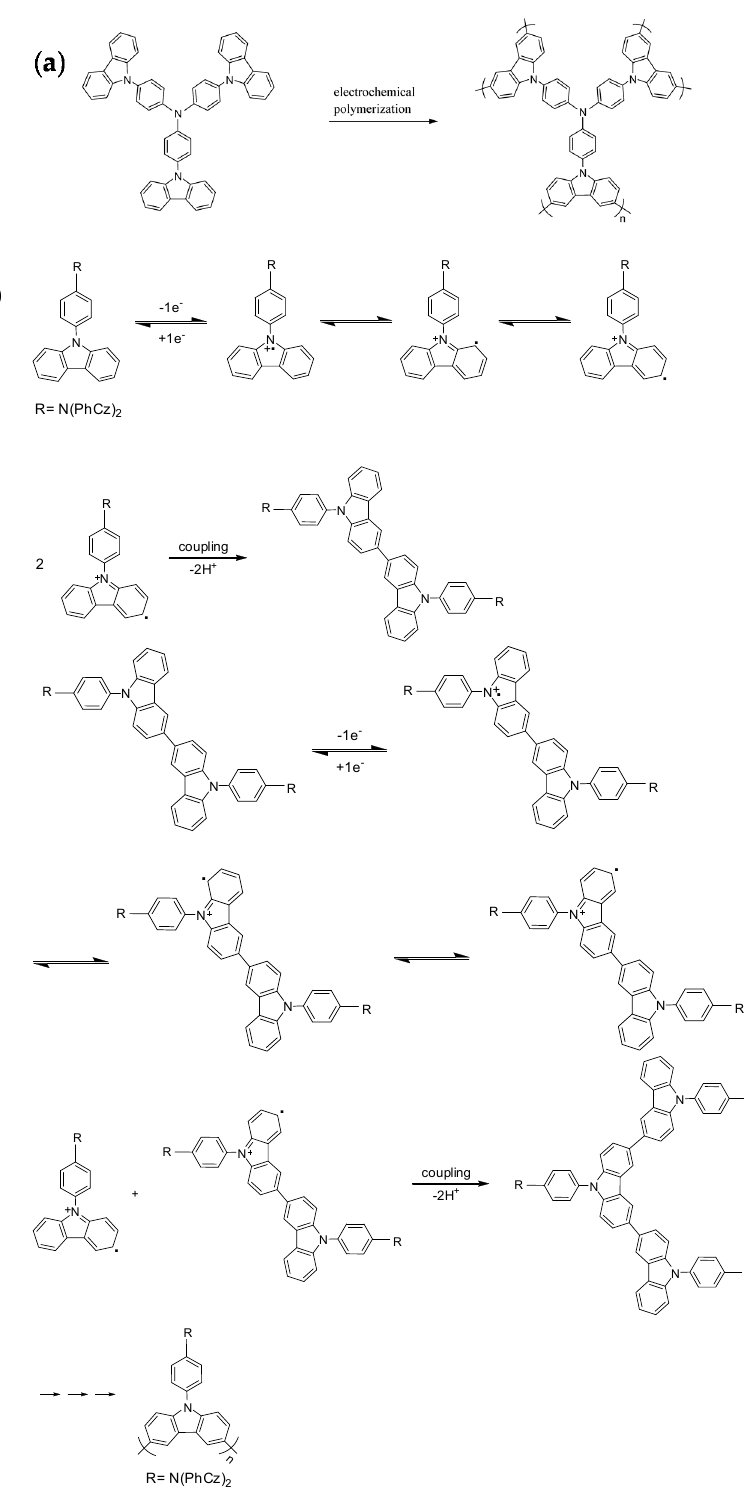
Figure 2. ( a ) The electrochemical polymerization scheme of the carbazole-based polymer (poly(tris(4- carbazoyl-9-ylphenyl)amine) (PtCz)); ( b ) the electropolymerization mechanism of PtCz.